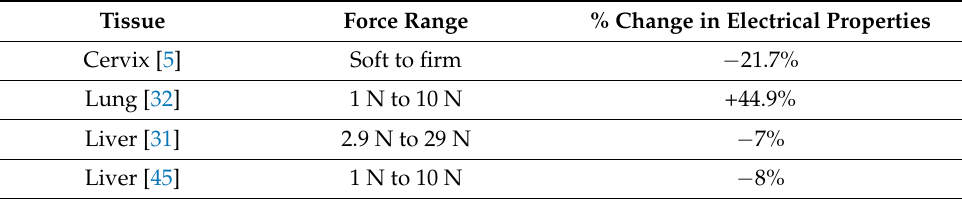
Table 2. Percentage change of the electrical properties of cervix, lung, and liver with monotonically increasing contact